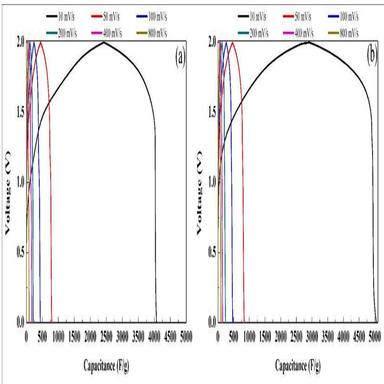
High-capacity charge-discharge behaviors at initial cycles of NiCeO2 (a), NiCeO2@f-MWCNT/EDA (b).